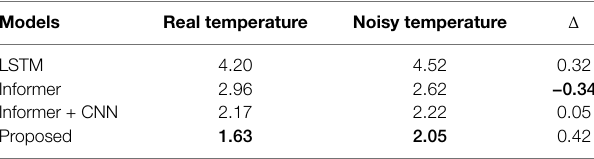
The bold values are the best results as compared to the others.